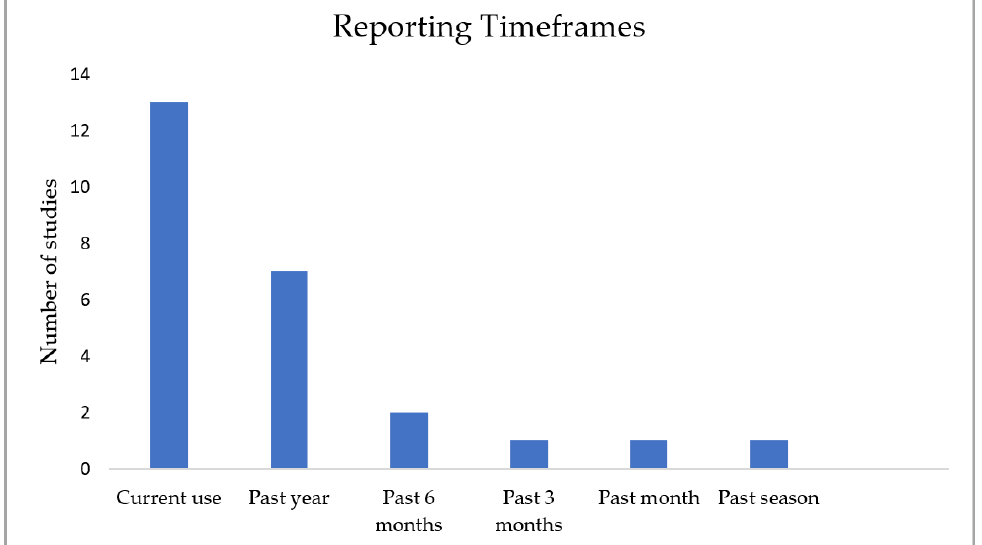
Figure 3. Reporting timeframes across studies.